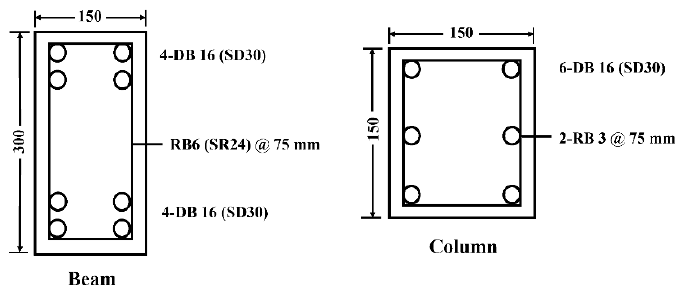
Figure 4. Cross-sections of the beam and column of Niyompanitpattana and Warnitchai [8]. Table 2. Material properties of Niyompanitpattana and Warnitchai [8].